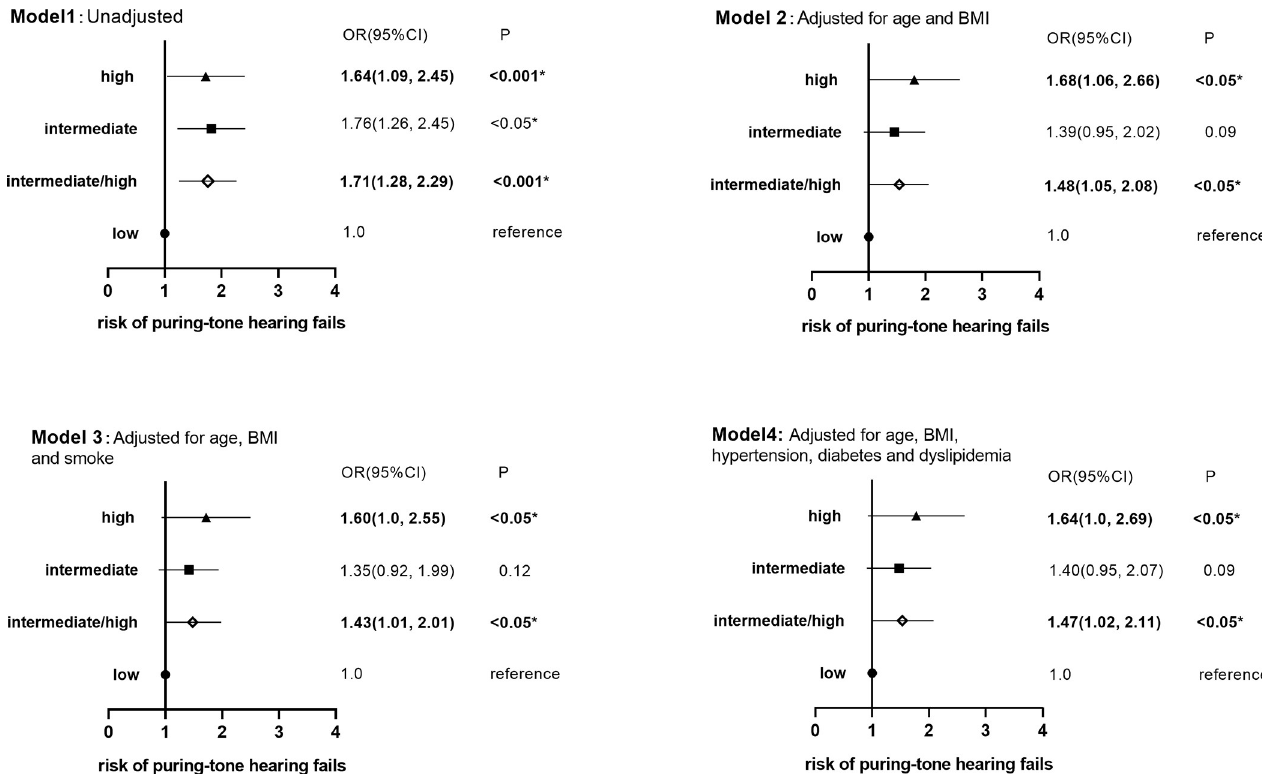
Fig 3. Multivariable models comparing the risk of pure-tone hearing fails grouped by OSA risk based on STOP-BANG scores. � : P � 0.05 (Model 2 adjusted for age and BMI. Model 3 adjusted for age, BMI and smoke. Model 4 adjusted for age, BMI, hypertension, diabetes and dyslipidemia.) Bold characters indicated statistical